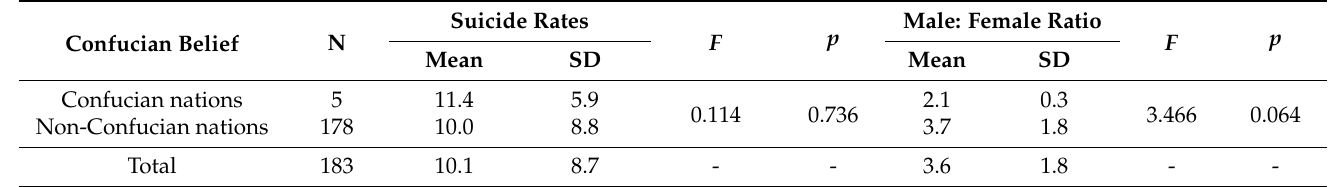
Table 1. Summary of the suicide rates and the gender ratios in the world by Confucian belief.